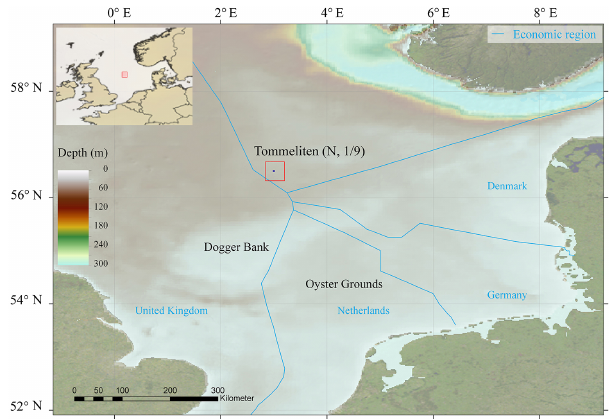
Figure 1. Map of the North Sea indicating the water depths and location of the Tommeliten site and the borders of the economic regions of the surrounding European